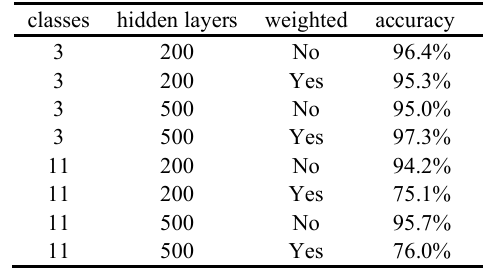
Table 1: Accuracy obtained by comparing the different training